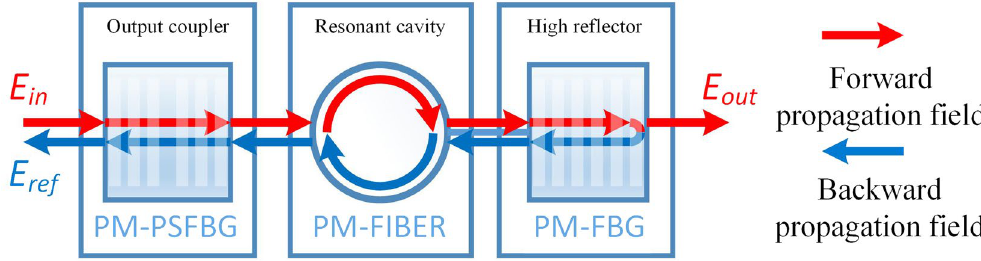
Figure 1. Sketch of PSFBG-F-FBG configuration. The red arrows and blue arrows indicate two counter propagating waves respectively. E in stands for the input light field, E ref for reflected light field, and E out for transmitted light